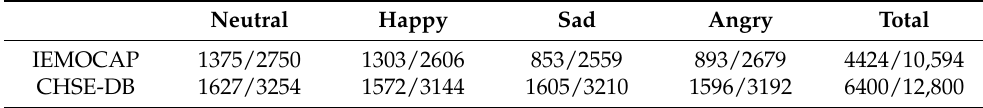
Table 2. Comparison of data quantity before and after use